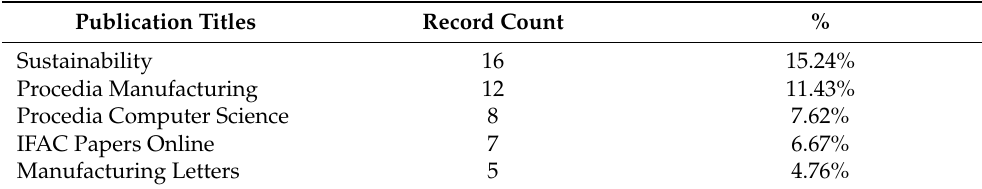
Table 3. Main source titles which contributed to the publication of scientific articles in scientific journals related to Industry 4.0 in the SME sector; Source: own